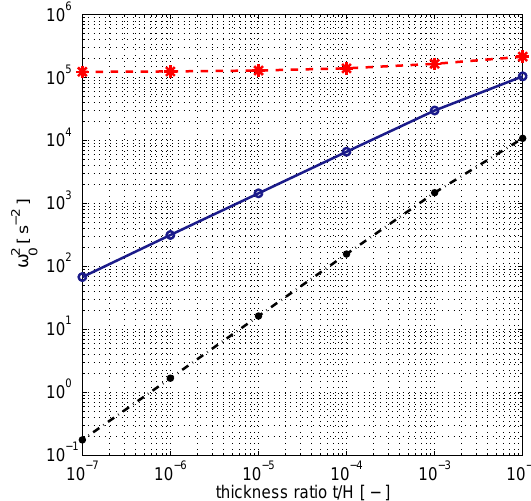
Figure 2. Asymptotic analysis of fundamental frequency. Asymptotic pattern of lowest eigenfrequency ω 0 with respect to thickness ratio t / H approaching zero. Different shells of revolution: elliptic - red dashed line with stars, parabolic - blue solid line with circles, hyperbolic - black dashed-dot line with